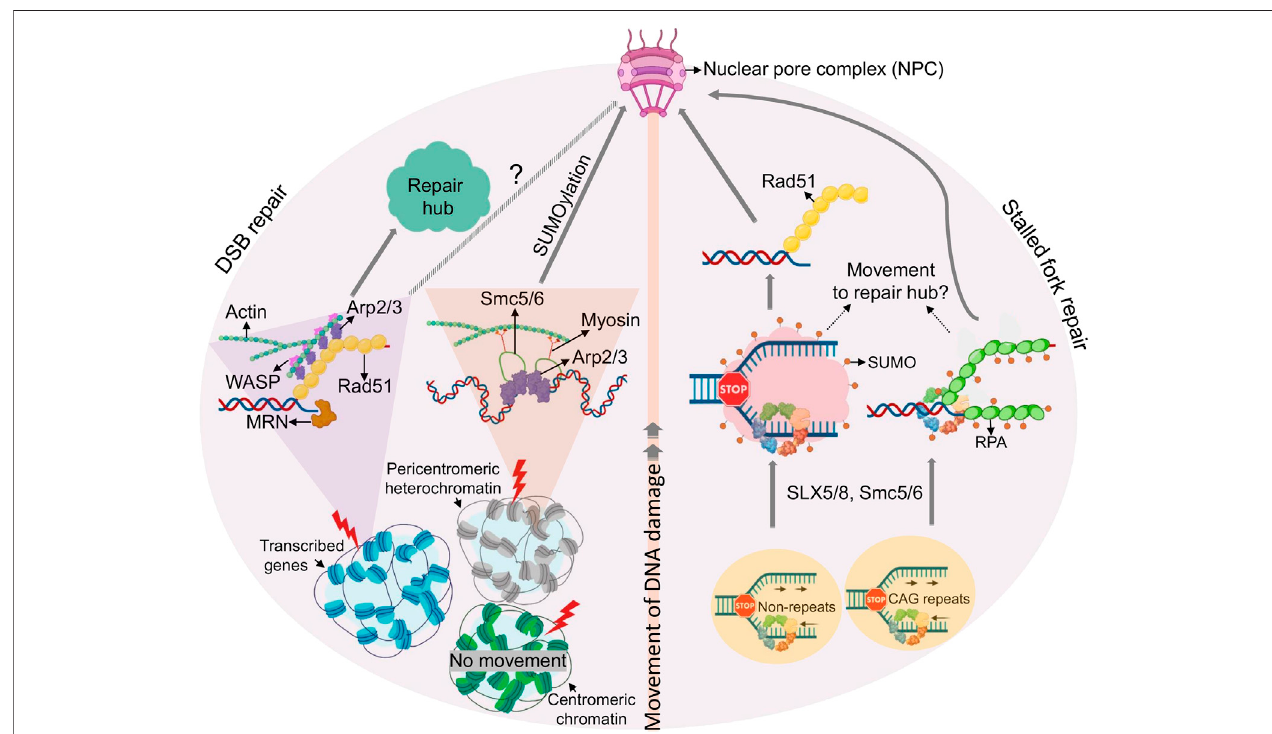
FIGURE 3 | Movement of DSBs and damaged replication forks. Emerging principles of DSB (left) or replication fork mobility (right) are shown. Clockwise from the bottom: Mechanisms of movement are different for DSBs induced in different chromatin environments (see text for details). In brief, DSBs in transcriptionally active chromatin load Rad51 after end resection and move to repair hubs facilitated by actin polymerization. DSBs in pericentromeric heterochromatin initiate resection, but relocateawayfromhetercochromatinviaanSMC5/6dependentprocesstofacilitateRAD51loading.PericentromericDSBs,andperhapsDSBswithintranscribed DSBs regions, are then targeted to the NPC in a manner that involves SUMOylation, myosin, and actin. Counterclockwise from the botton: Stalled replication forks relocatetotheNPCinaprocessinvolvingSUMOylationbySmc5/6and/orSLX5/8(shownasreddots).ForksinrepetitivesequencesaretargetedtotheNPCviaSUMO- RPA, prior to Rad51 loading, whereas arrested forks at non-repetitive genomic loci are targeted to NPC after RAD51